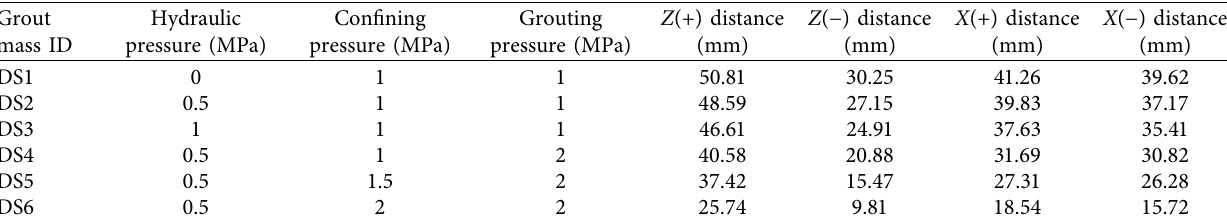
Table 4: Measured diffusion